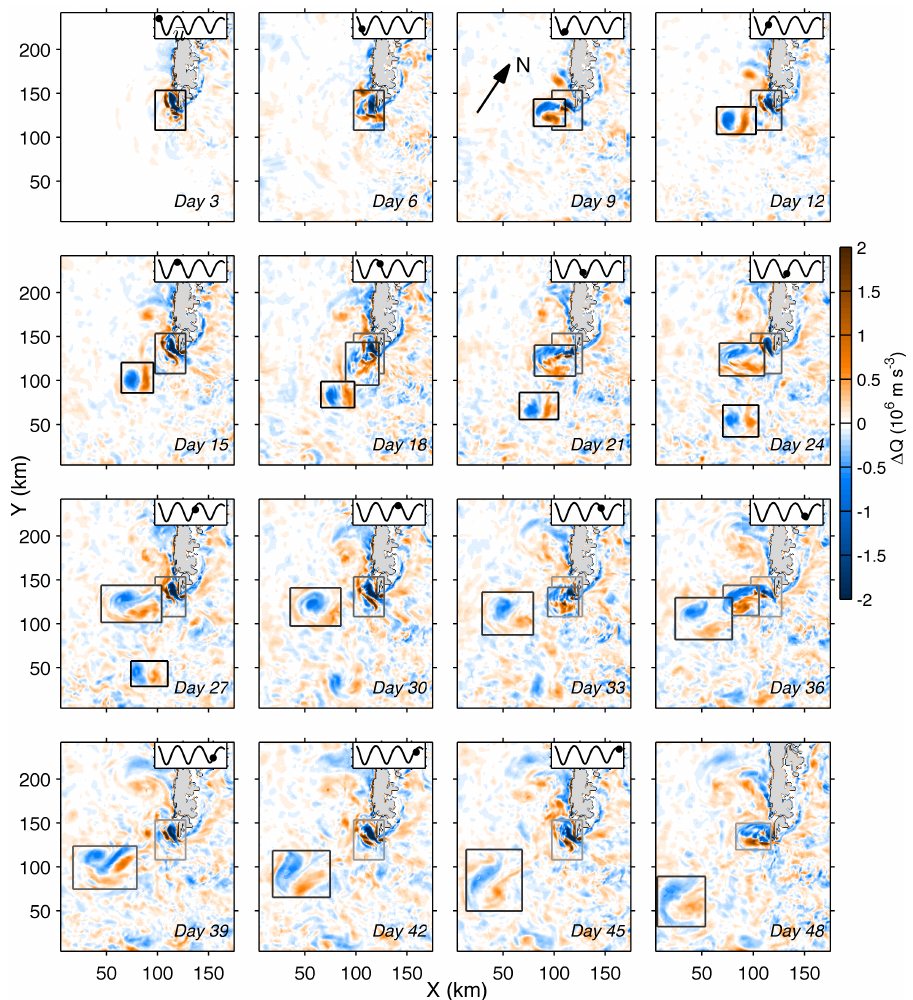
Fig. 3. Integrated PV in coalescing eddies over the whole model run showing the propagation of dipoles offshore. PV has been integrated from σ θ = 26kgm − 3 , or approximately 100-m depth, to the surface. Gray boxes indicate eddy dipoles tracked below. Note the change in the color limits compared to Fig. 5. The inset box in each panel is the envelope of mean cross-shelf tidal velocity in a 5-km box near the cape, with a dot representing the tidal velocity for the panel pictured. Highs denote spring tides, lows are neap tides.